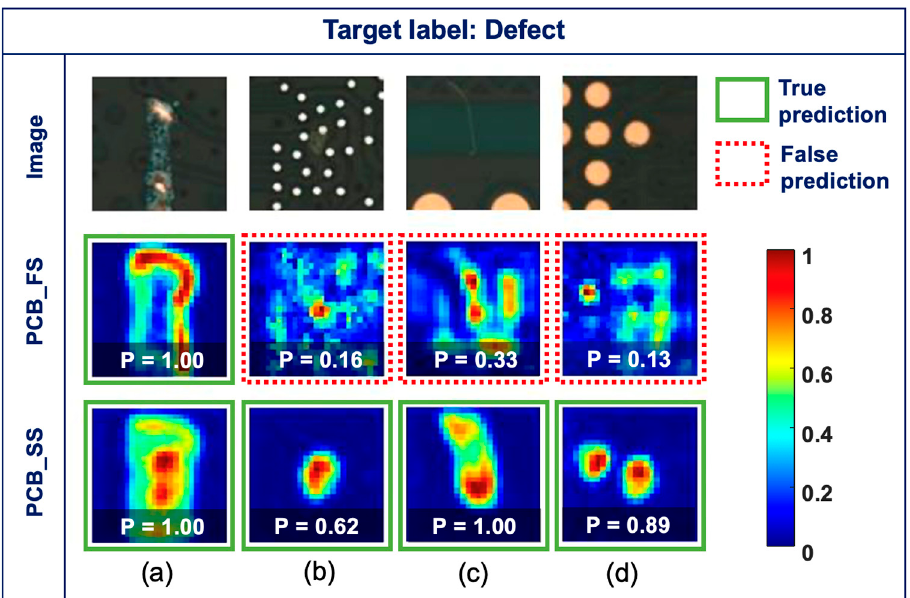
Figure 8. Original images (top row) and Grad-CAM maps obtained using the PCB_FS model (middle row) and PCB_SS model (bottom row) ( a ) true predictions for both PCB_FS and PCB_SS models, ( b – d ) false and true predictions for PCB_FS and PCB_SS models, respectively (green solid box: true prediction, red dotted box: false prediction).